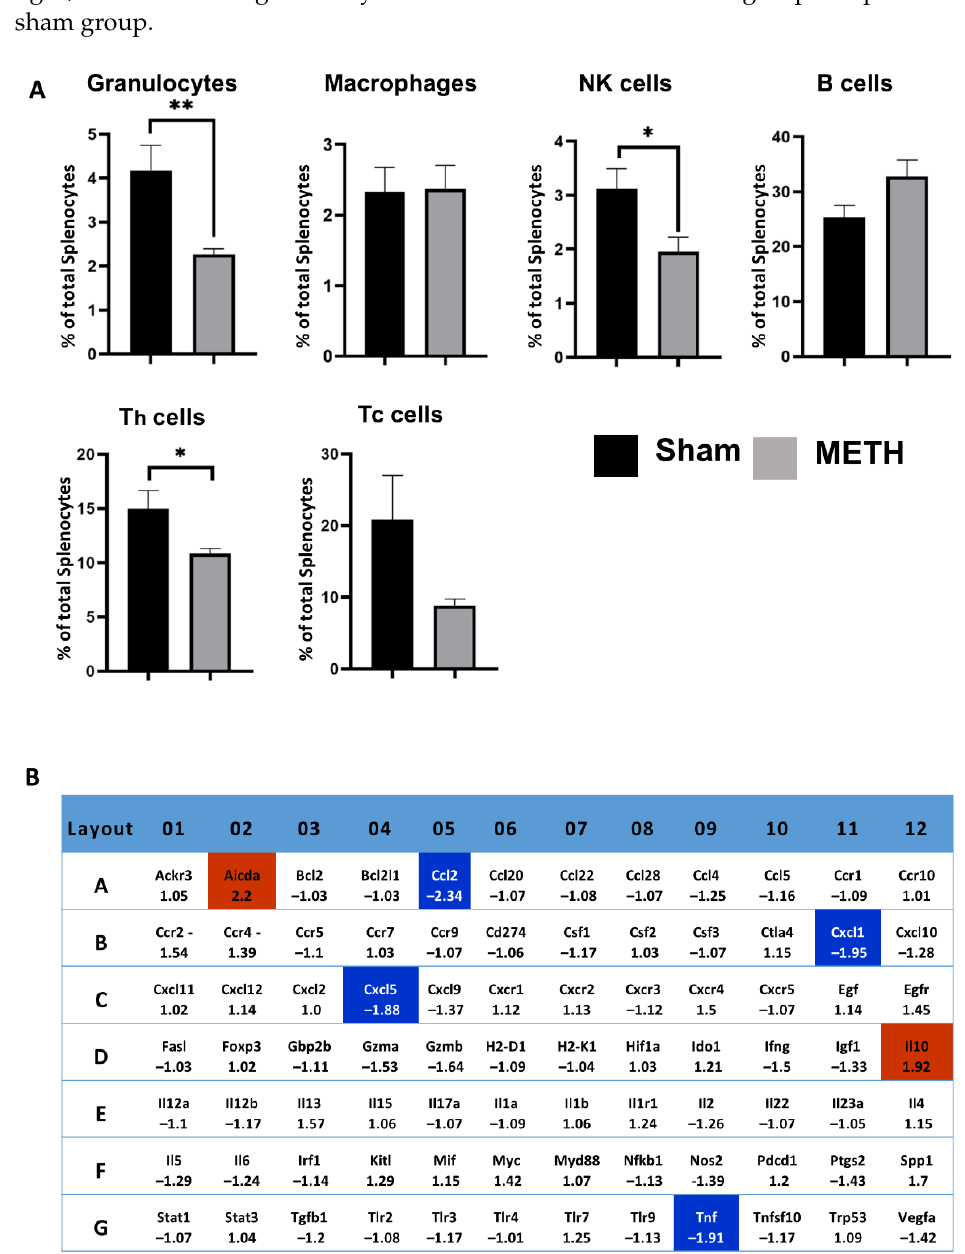
Figure 8. Cellular and gene changes in the spleen. ( A ) Percentage of splenocyte cells (granulocytes, macrophage, natural killer (NK) cells, B cells, helper T (Th) cells, and cytotoxic T (Tc) cells), at time = 3 h following METH administration. Figures show % total splenocyte cells ± standard error of the mean (SEM) with respect to the mean of shams, ** p < 0.01, * p < 0.05. ( B ) RT 2 Profiler PCR gene array showing upregulated (red) and downregulated (blue) fold-change mRNA gene expression in the spleen of the sham- and METH-treated groups.